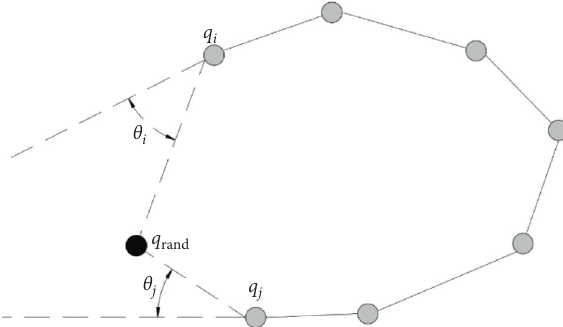
Figure 9: Schematic diagram for selecting the nearest node.